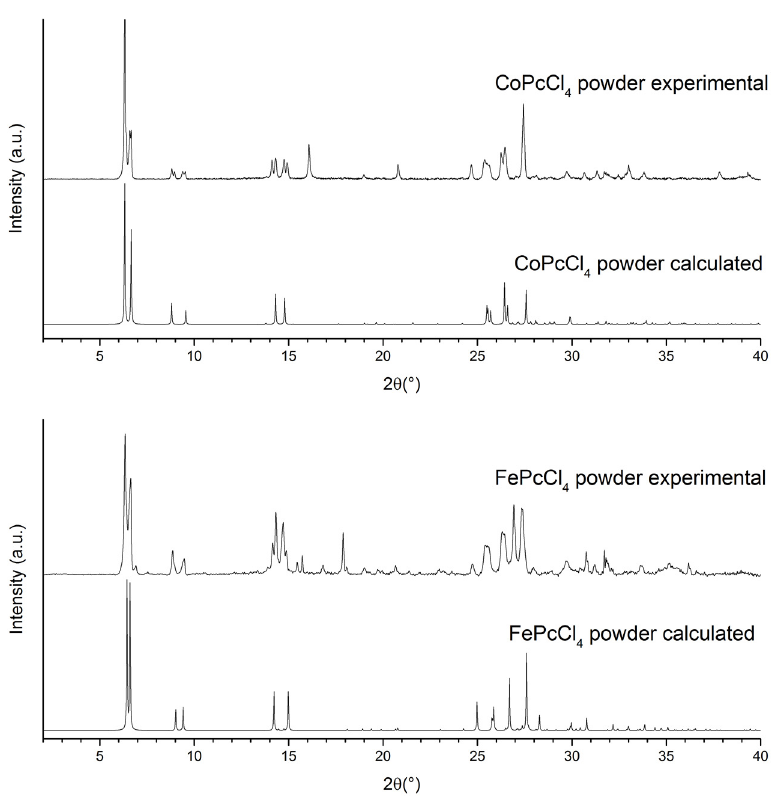
Figure 4. Experimental and calculated powder diffraction patterns of CoPcCl 4 and FePcCl 4 (CuK α , λ = 1.54187 Å). λ = 1.54187